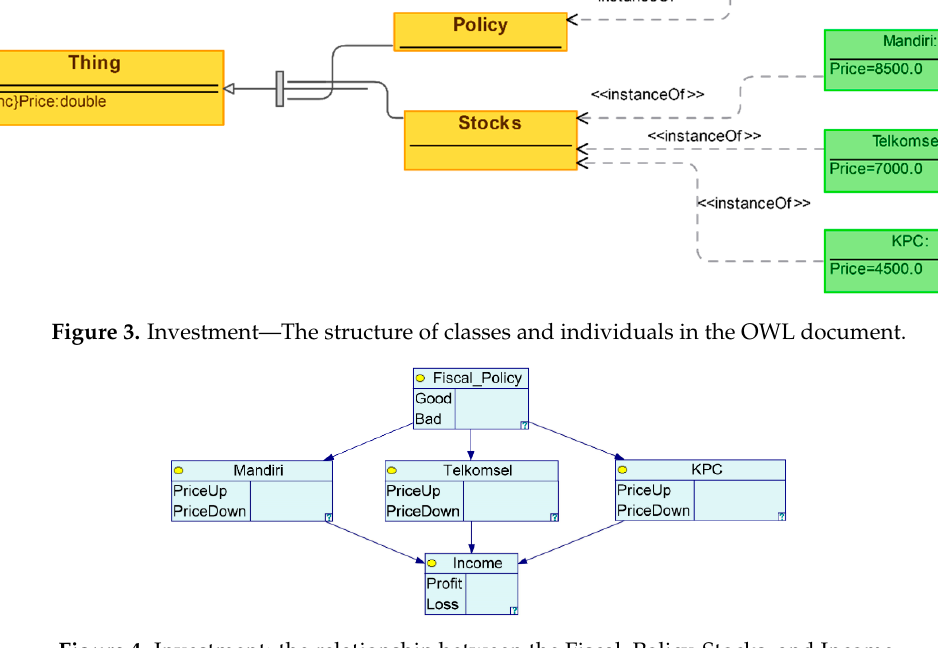
Figure 4. Investment: the relationship between the Fiscal_Policy, Stocks, and Income.